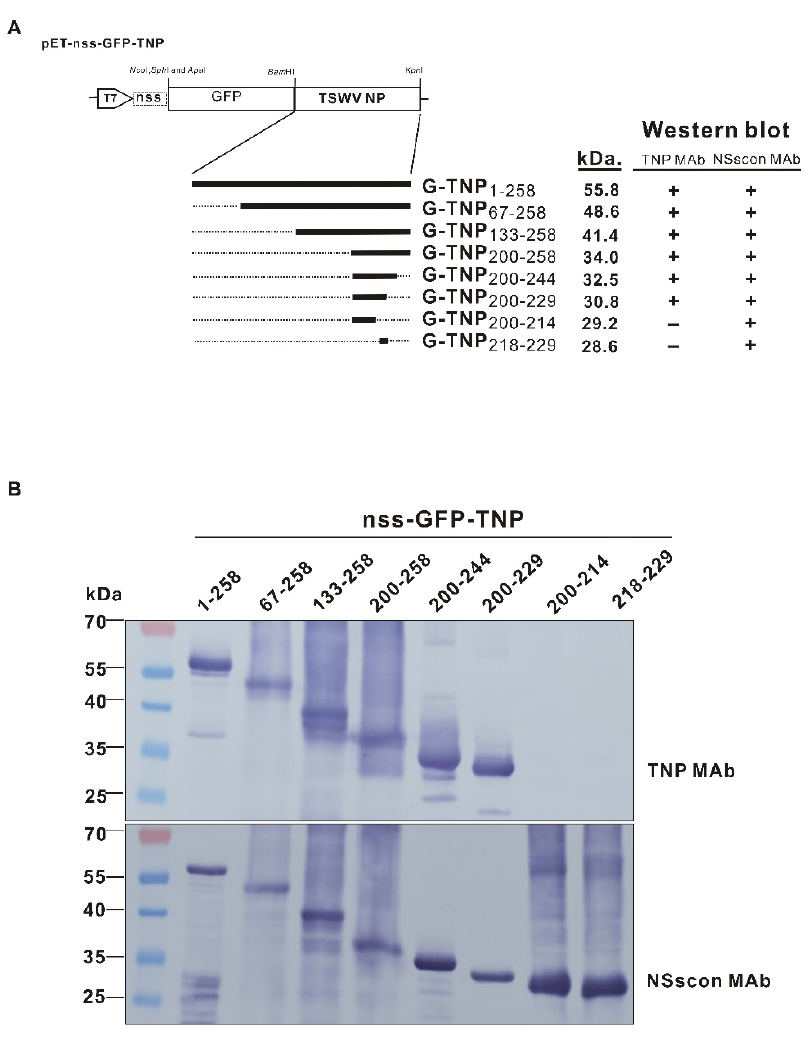
Figure 3. Mapping of the TSWV NP sequence recognized by the monoclonal antibody TNP MAb. ( A ) The construction of the bacteria-expressing vector, pET-nss-GFP-TNP1-258, containing the entire length (258 aa) or the various deletions of the tomato spotted wilt virus (TSWV) NP fused with the C-extreme of GFP. The thick solid lines indicate the NP sequences, and the numbers indicate the actual lengths of the deleted NPs. G-TNP 1-258 indicates GFP fused with full-length NP. ( B ) Western blot detection of recombinant GFPs fused with various sizes of TSWV NP by TNP MAb (this study) or NSscon MAb [37]. All reactions are also indicated in panel ( A ).